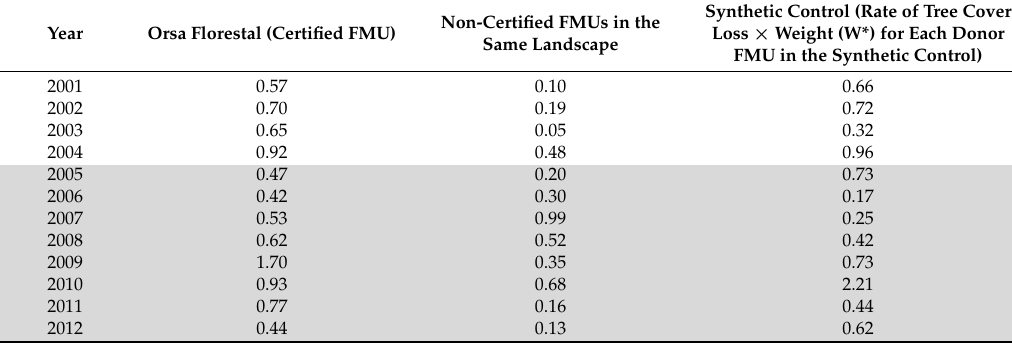
Table 1. Percent of tree cover lost annually in forest management units (FMUs) in the Estuário Landscape of the Brazilian Amazon. Shaded rows correspond to years after Forest Stewardship Council (FSC) certification of Orsa Florestal.